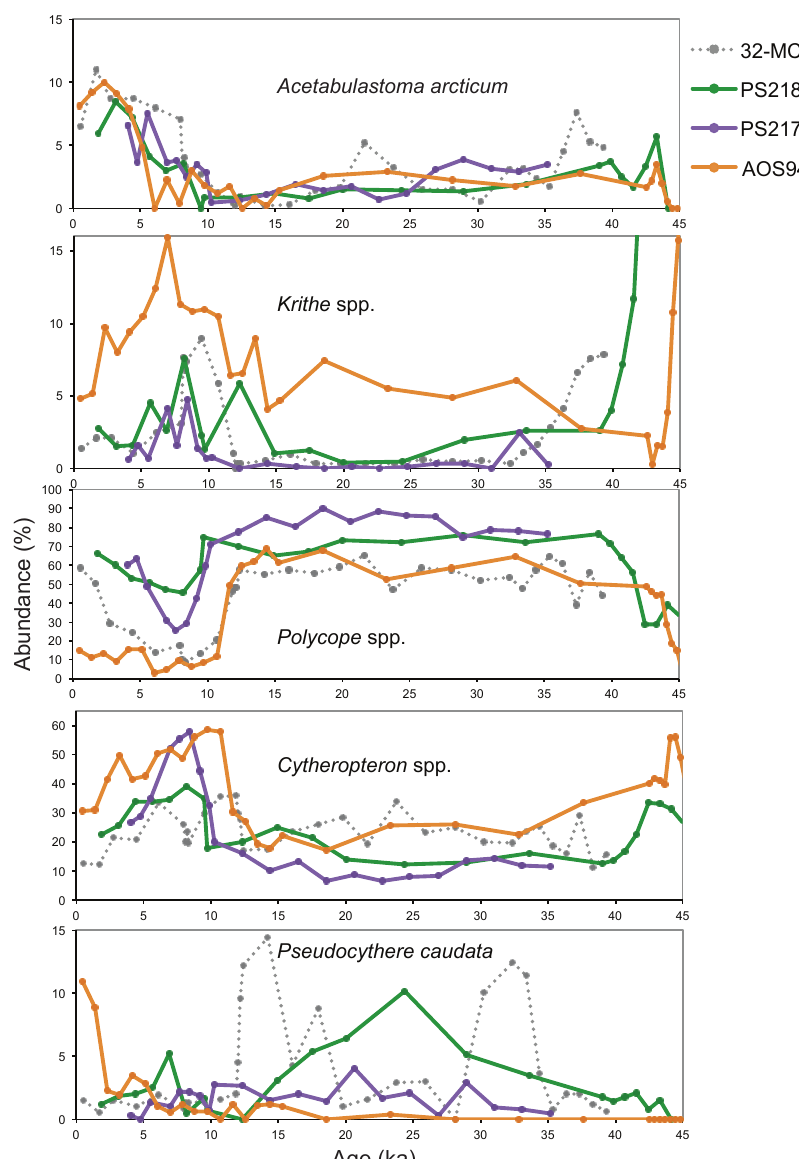
Figure 4. Relative frequencies (percent abundance) of dominant taxa in SWERUS 32-MC (dotted line) compared to other Lomonosov Ridge cores 2185, 2179 and AOS94 28 (Poirier et al., 2012). The chronology for core PS 2185-4 MC (1051m) is described in Jakobsson et al. (2000), Nørgaard-Pederson et al. (2003), and Spielhagen et al. (2004), core PS 2179-3 MC (1228m) in Nørgaard-Pederson et al. (2003) and Poirier et al. (2012), and core AOS94 28 (PI-94-AR-BC28, 1990m) in Darby et al.